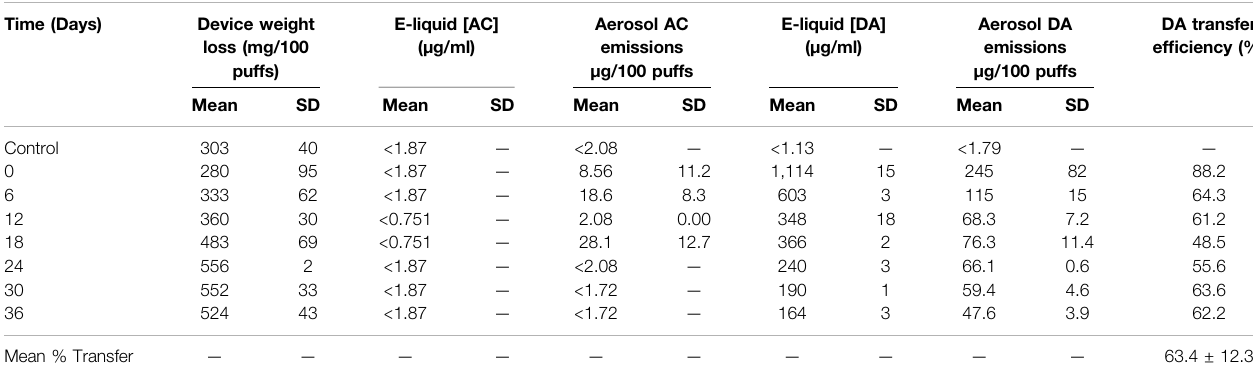
TABLE 2 | Transfer of diacetyl from e-liquid to e-cigarette aerosol.